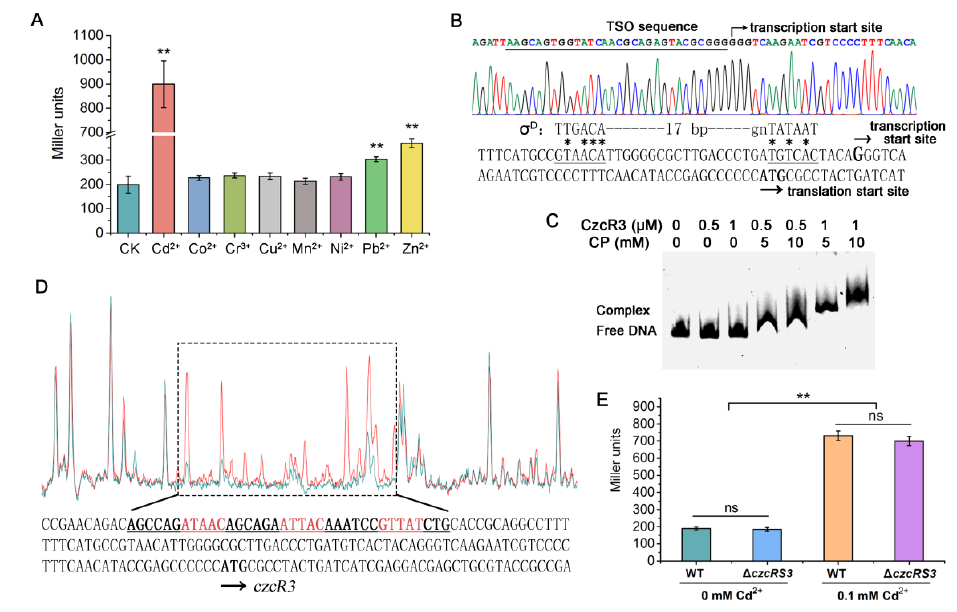
Figure 4. The regulation of czcRS3 expression. ( A ) Induction of heavy metals on czcRS3 expression. The expression level of czcRS3 in wild-type KT2440 was detected by reporter plasmid pBRTZ- czcR3 after treatment with heavy metals at a concentration of 1/5 MIC for 4 h. ( B ) Identification of the transcription start site of czcRS3 operon by 5 ′ -RACE assay. The underlined − 10 and − 35 elements show similarity to the recognition sequence of σ D (* indicates the matched DNA bases). ( C ) The affinity of CzcR3 for czcRS3 promoter in presence of carbamyl phosphate (CP). ( D ) Identification of the CzcR3-binding site on czcRS3 promoter. The promoter probes were incubated with CzcR3 (blue peak) or BSA (red peak, as control) in DNase I footprinting assay. The region in the dashed box represents the binding region of CzcR3 on the promoter. ( E ) The regulatory role of CzcRS3 in self-expression. The data represent the mean ± standard deviation of three replicates. The significant difference was determined by Student’s t -test (** p < 0.01; ns, non-significant, p > 0.05).